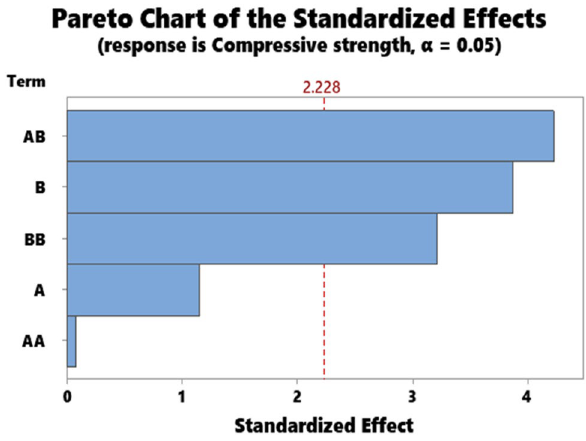
Figure 9. Pareto chart for compressive strength.